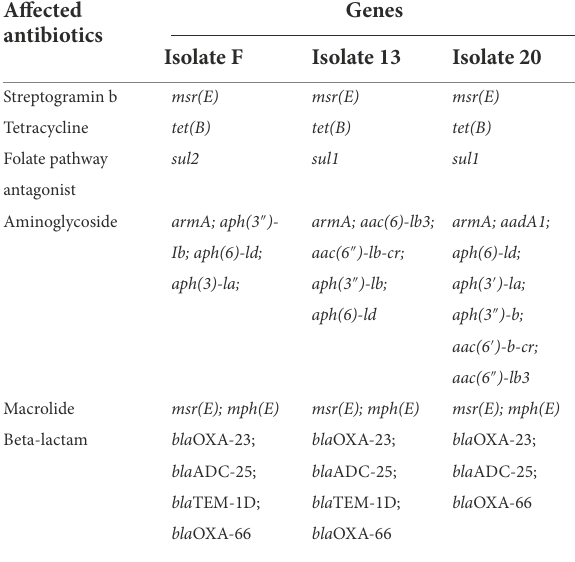
TABLE 1 Drug resistance genes of Acinetobacter baumannii